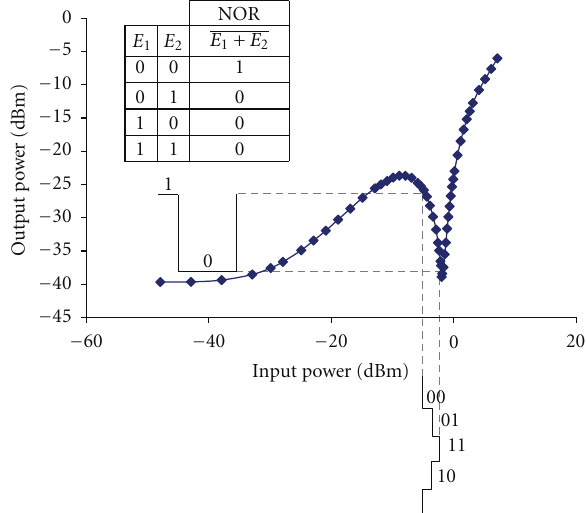
Figure 6: Measured static transfer function and principle of ope- ration for NOR function at a blocking power equal to − 2 dBm and wavelength equal to 1550